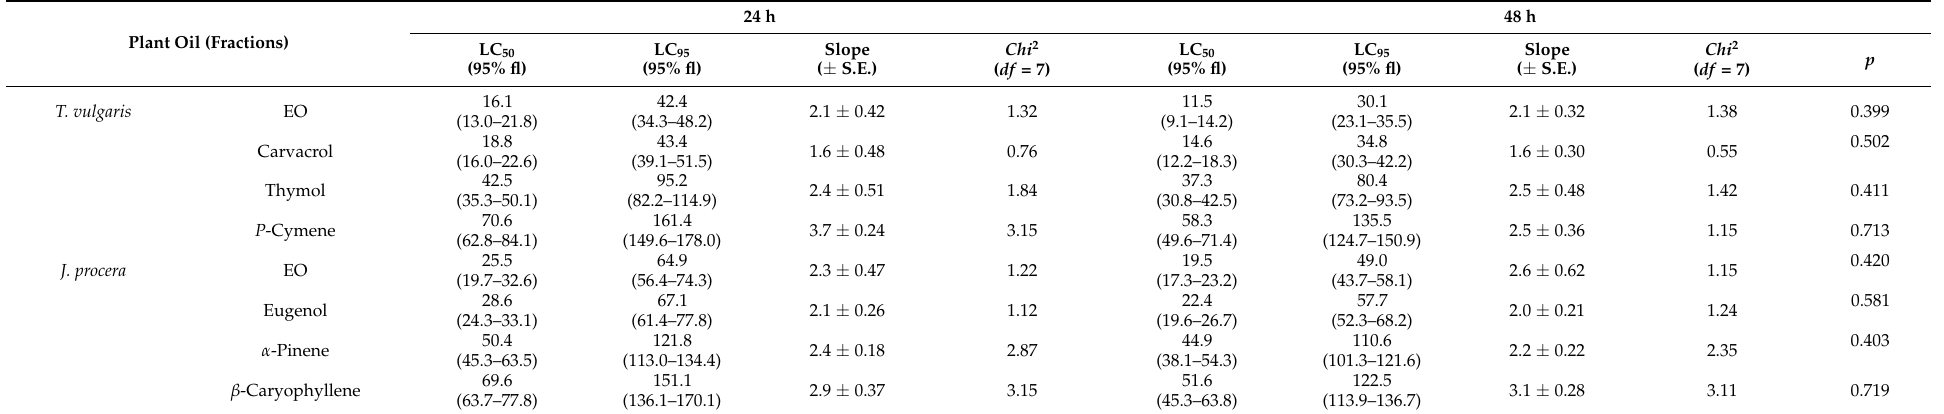
Table 3. Contact adulticidal activity ( µ L/cm 2 ) of the tested oils and their terpenes against T. granarium using the filter paper bioassay. Plant Oil